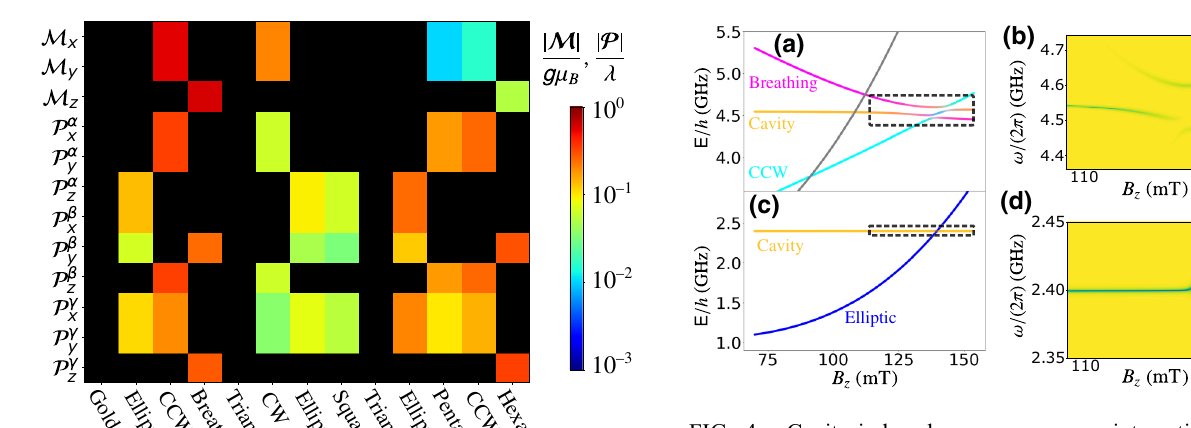
FIG. 4. Cavity-induced magnon-magnon interaction and MP hybridization of the magnetically dark elliptic mode. (a),(c) Mag- netic field dependence of the magnon-photon spectrum of the low temperature SkX, obtained at D / J = 0.5 and ˆ z (cid:9) [001]. The Planck constant is denoted as h . The color code indicates the probability density of cavity mode (dark yellow) and skyrmion excitations including breathing (magenta), CCW (cyan), and elliptic (blue) modes. (b),(d) Calculated microwave reflection (ω) | 2 using the input-output formalism [44,70] (cf. Appendix | S 11 H), obtained for regions enclosed by black dashed lines in (a) and (c). The cavity field directions are fixed as (a),(b) E (cid:9) [110] and B (cid:9) [001] at (cid:3)/( 2 π) = 4.55 GHz and (c),(d) E (cid:9) [001] and B (cid:9) [110] at (cid:3)/( 2 π) = 2.4 GHz. In (a)–(d), we assume that the SkX is placed slightly away from the antinode of the electric component of the cavity mode with | B | ≈ 0.1 B 0 and | E | ≈ 0.995 E 0 . We also assume that the damping rate of cav- ity mode κ a /( 2 π) = 1 MHz, the damping rate of the n th magnon mode κ n /( 2 π) = 20 MHz, and η = 0.1. The energy eignenval- ues E and magnetic fields are rescaled for Cu 2 OSeO 3 at 5 K (cf. Appendix